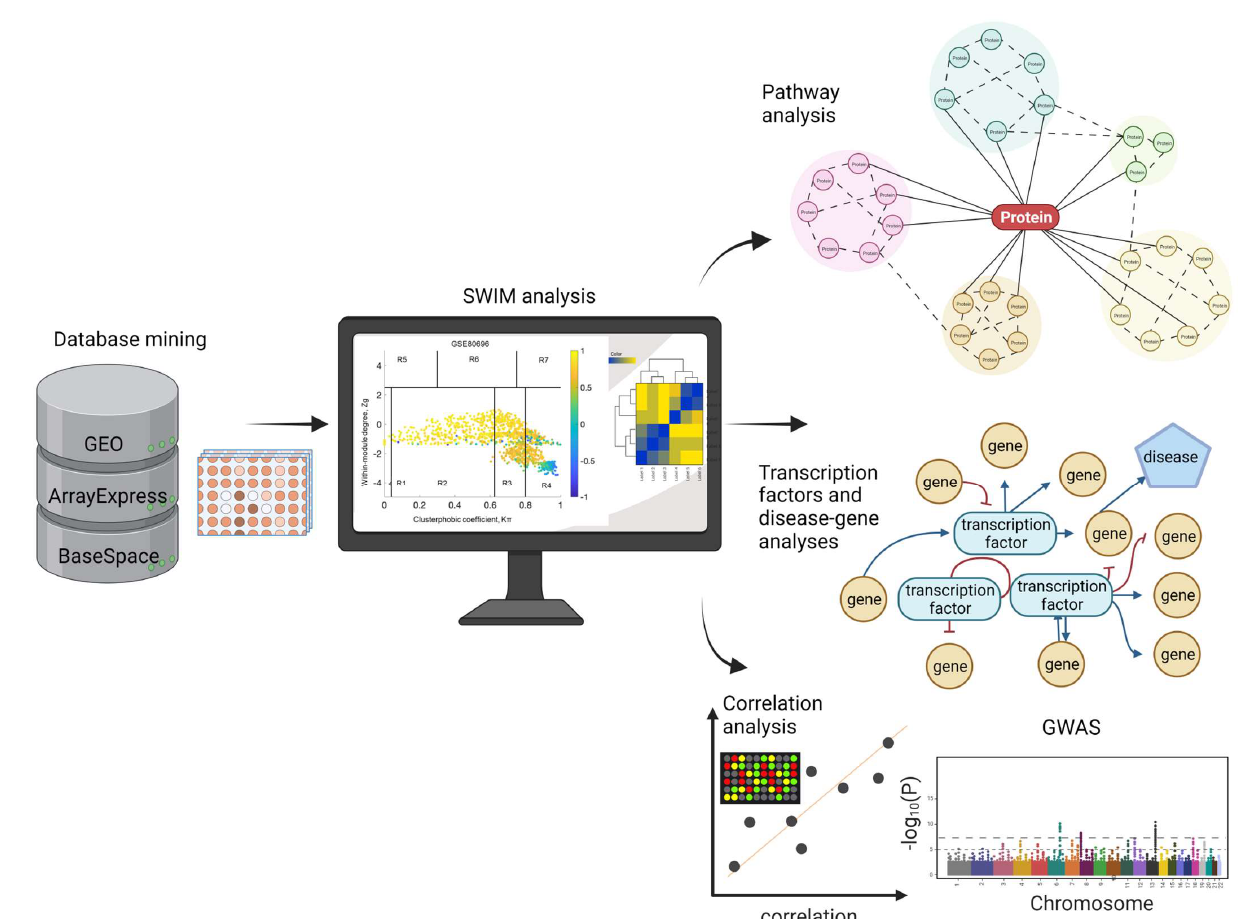
Figure 1. Overall bioinformatics workflow. We searched the GEO, ArrayExpress, and